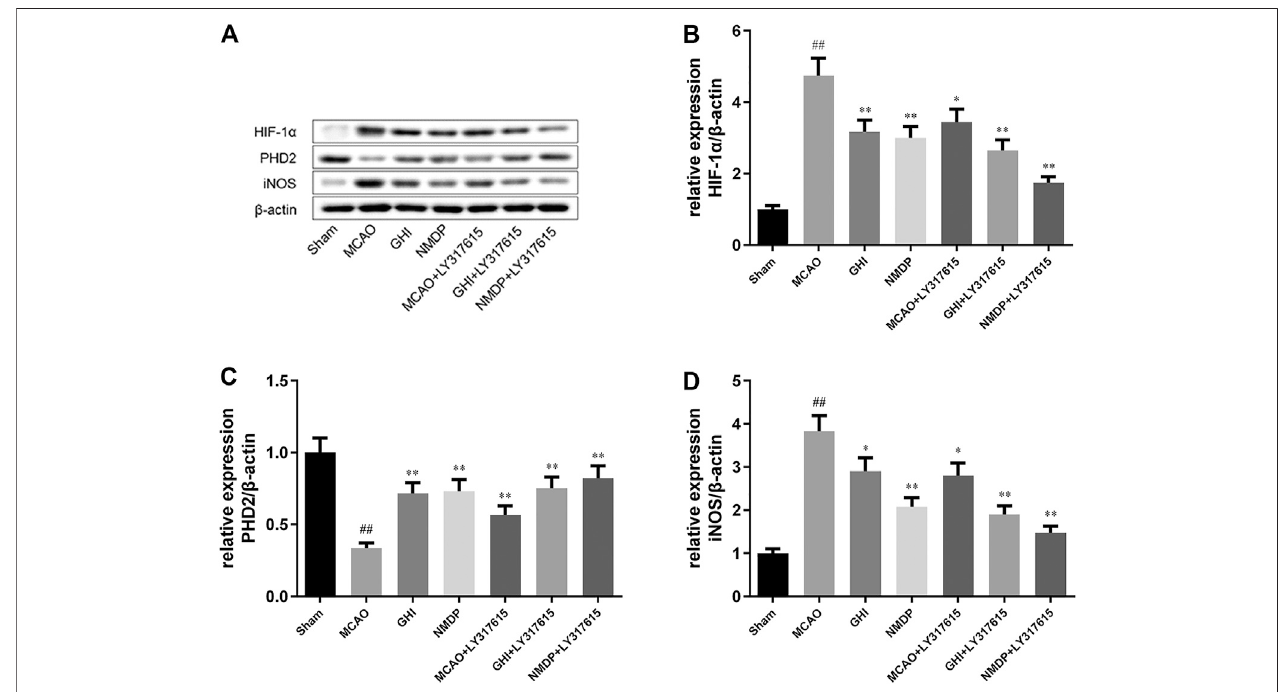
FIGURE 7 | Representative photographs ofWestern blotting (A) ; the expression of HIF-1 α (B) , PHD2 (C) , iNOS (D) protein in rat after I/R for each group ( x ± SD, n (cid:1) 3). #, compared with the Sham group; *, compared with the MCAO group; “ ## ” and “ ** ” means that the p value is less than 0.01; “ # ” and “ * ” means that the p value is less than 0.05.